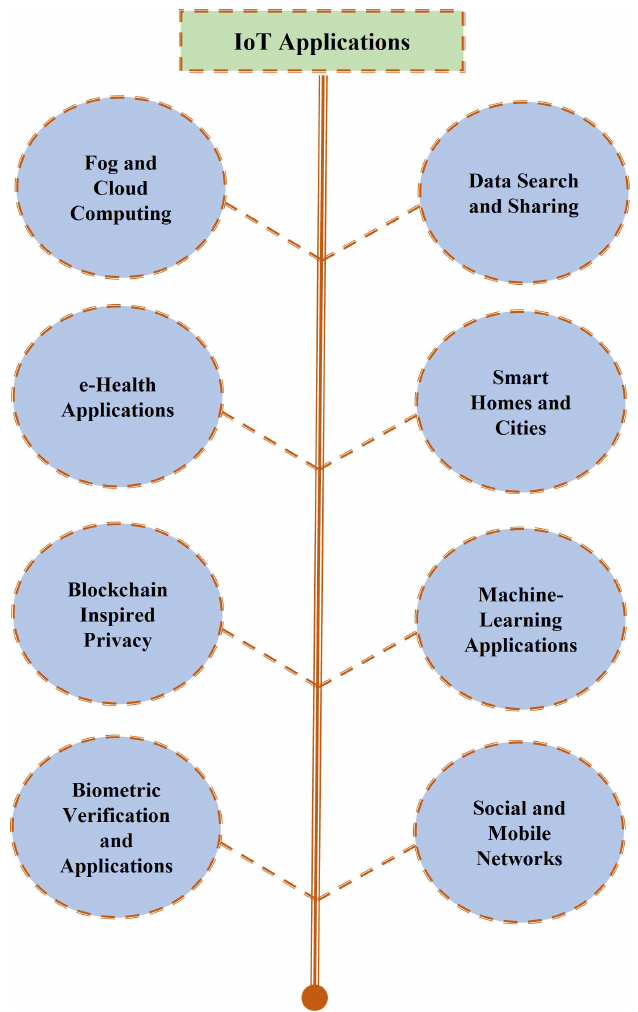
Figure 7. Application areas for FE and encompassed primitives considered in this